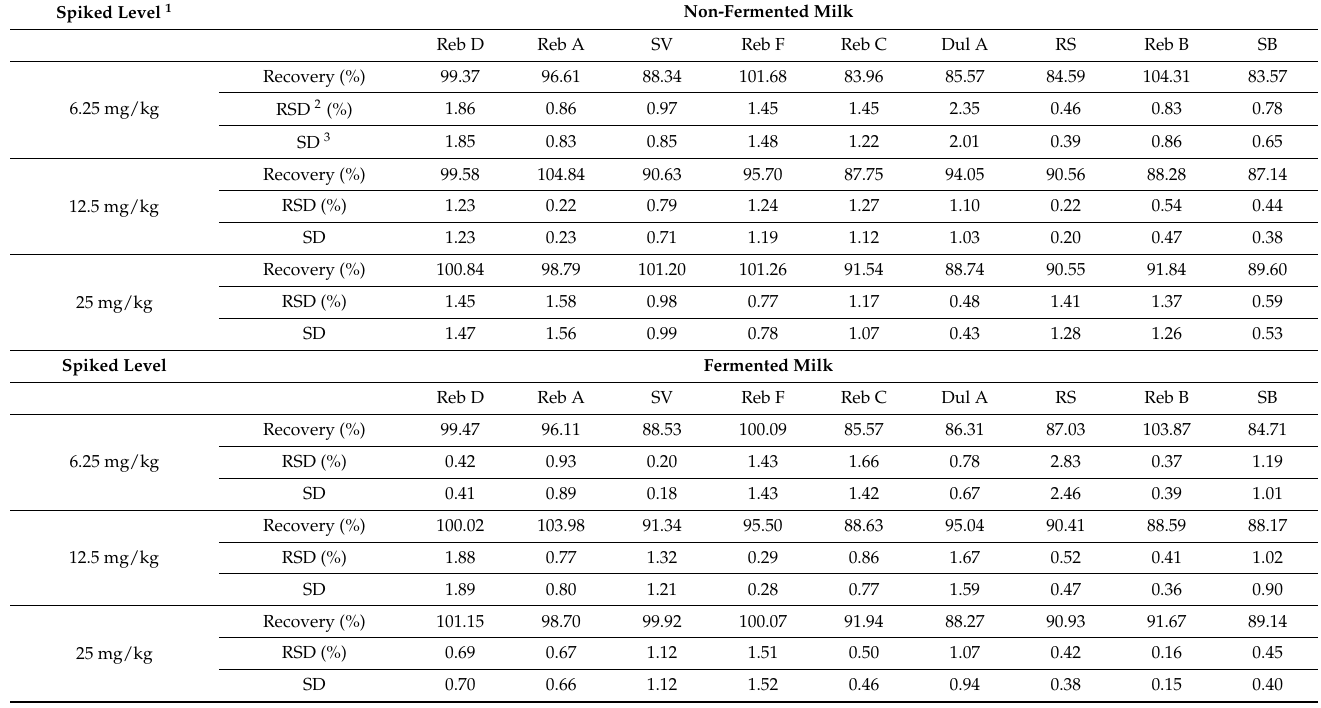
Table 2. Recovery test on non-fermented and fermented